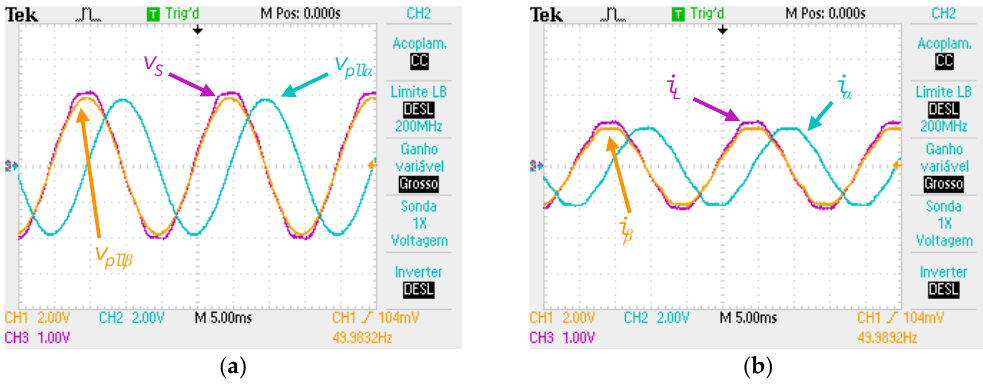
Figure 22. Creation of a three-phase virtual balanced system from a single-phase installation for the application of the p - q theory: ( a ) Source voltage ( v S ) and PLL output signals in the α - β coordinates ( v pllα and v pllβ ); ( b ) Load currents in the α - β coordinates ( i α and i β ).